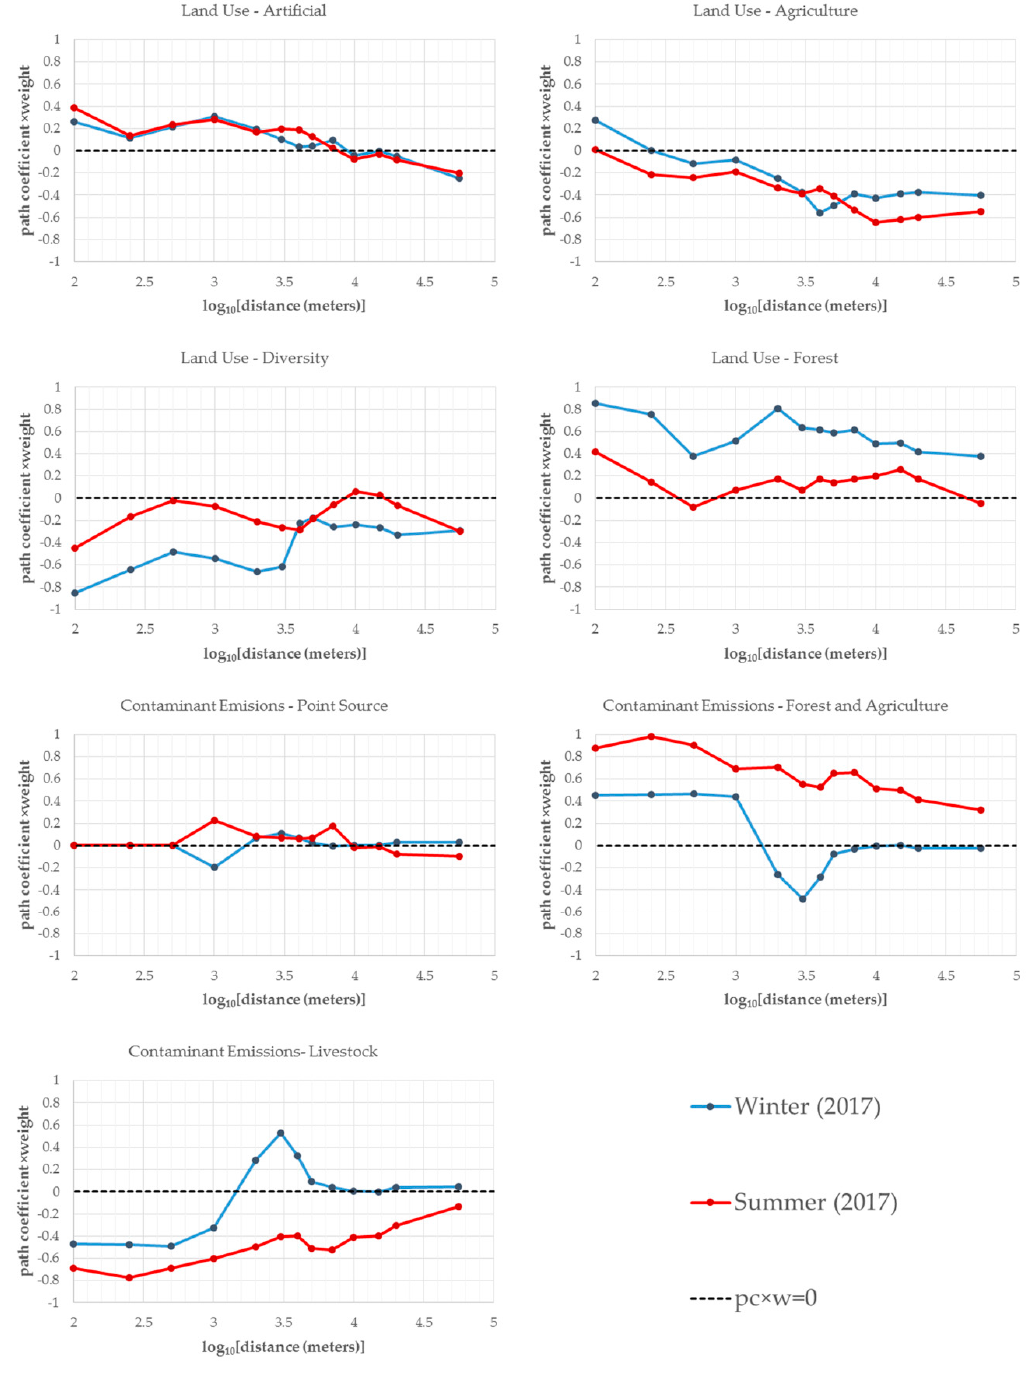
Figure 5. PLS-PM Figure 5. PLS-PM results.